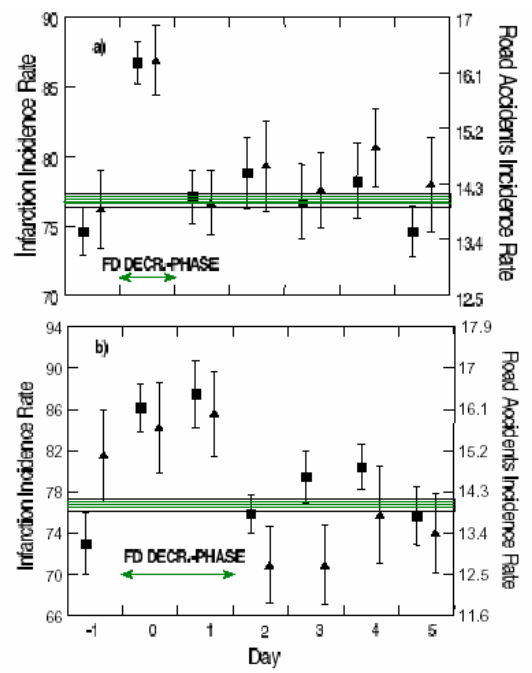
Fig 2. Fig. 2. Infarction (full squares) and road accident (full triangles) incidence during the time development of an FD: (a) CR decrease phase T < 1 day; (b) CR decrease phase 1 day < T < 2 days. With horizontal lines are shown average values for days without